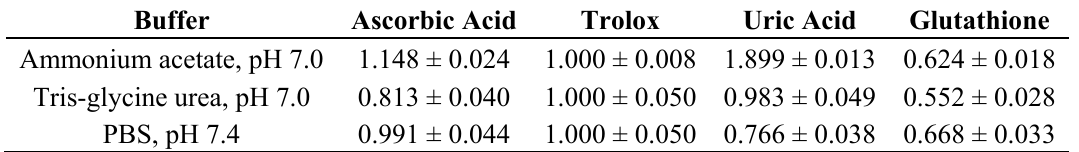
Table 3. Comparison of Trolox equivalent values (TE) obtained for the antioxidant compounds, in different buffer solutions using BCS as a complexing agent. Buffer Ascorbic Acid Trolox Uric Acid Glutathione Ammonium acetate, pH 7.0 1.148 ± 0.024 1.000 ± 0.008 Tris-glycine urea, pH 7.0 0.813 ± 0.040 1.000 ± 0.050 PBS, pH 7.4 0.991 ± 0.044 0.668 ±